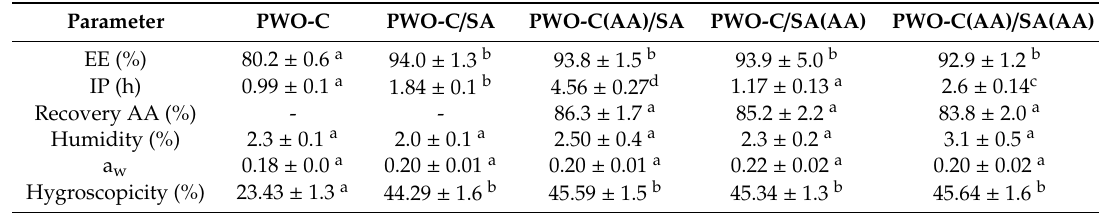
Table 1. Characterization of PWO microparticle